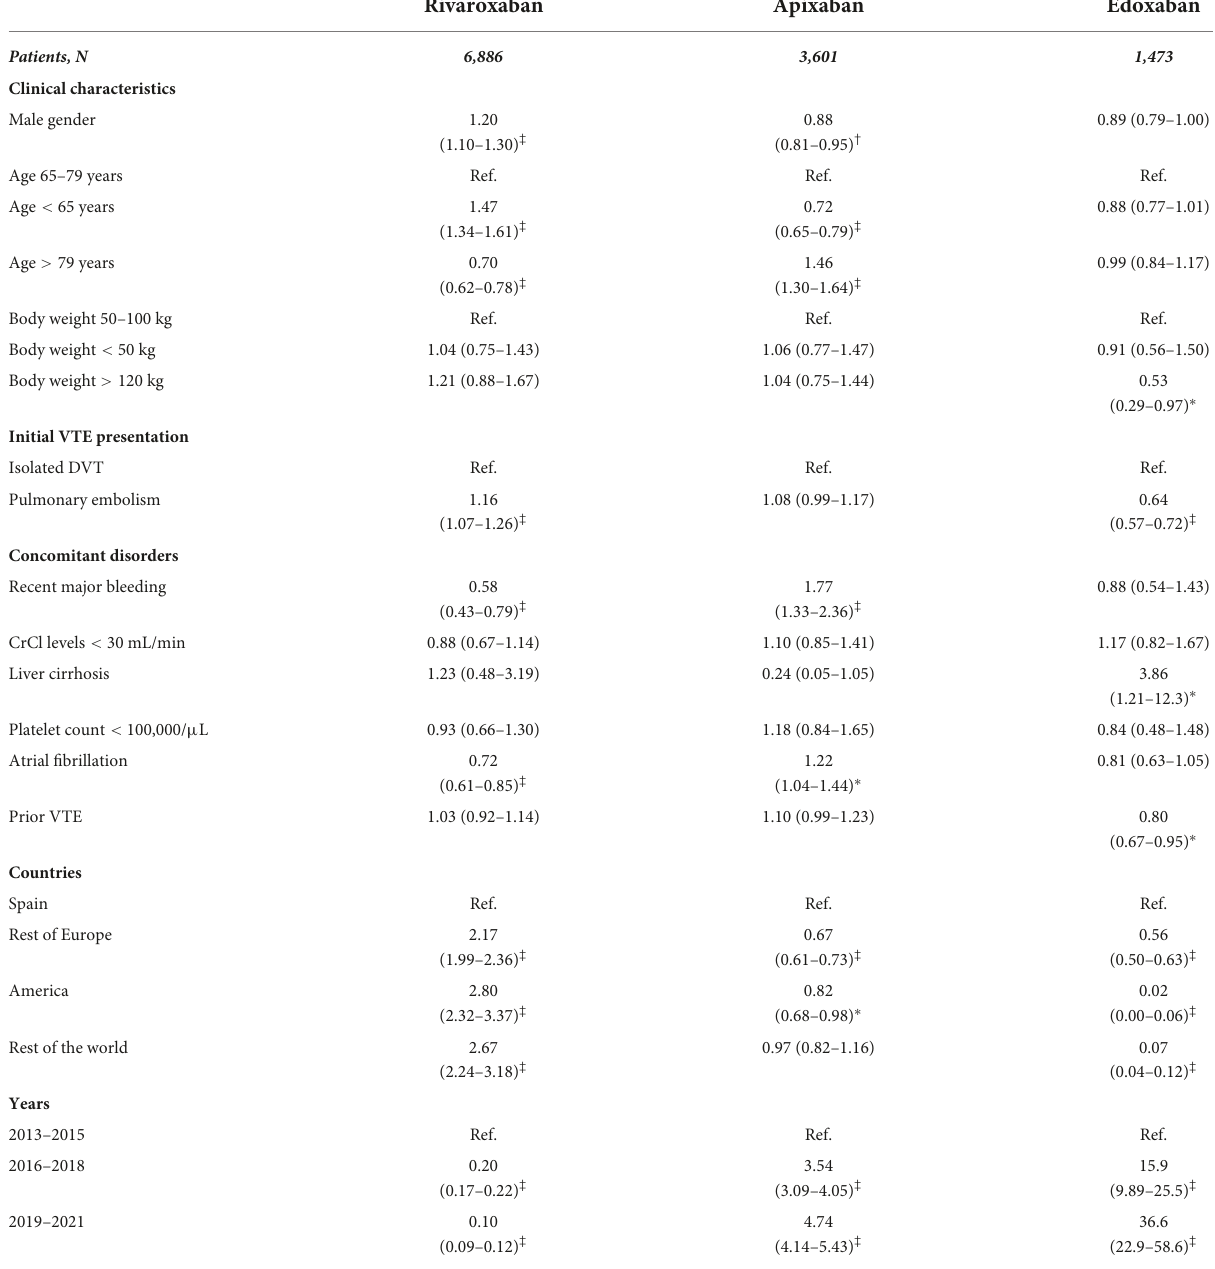
TABLE 3 Multivariable analyses for predictors of use of every DOAC (vs. the rest of